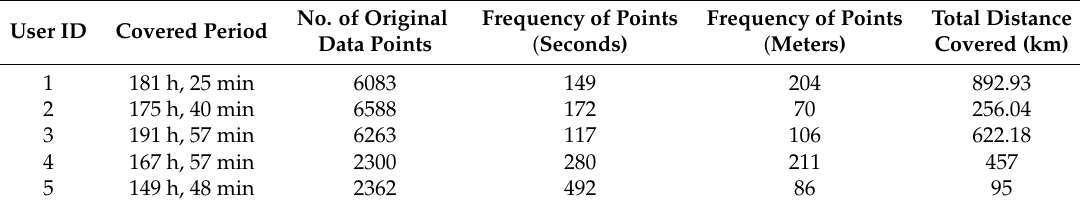
Table 2. Data collection